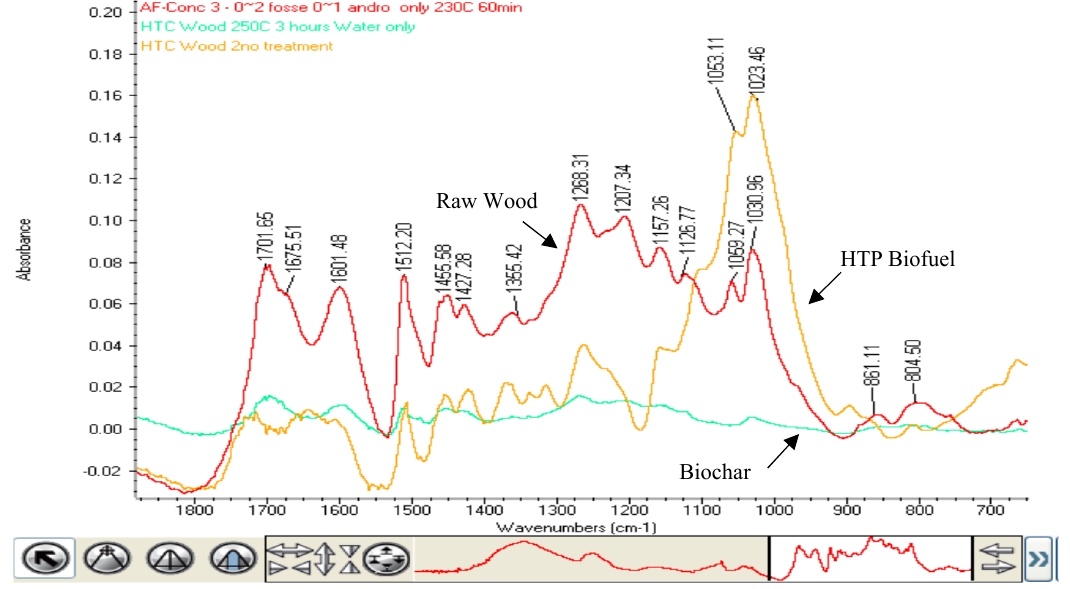
Figure 5. FTIR spectrum of FINGERPRINT region of MID INFRARED SPECTRUM. The three samples are raw wood, biofuel from HTC and biochar from the HTC process where no catalyst is used.